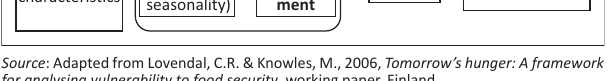
FIGURE 1: A framework for access to food in vulnerable contexts.